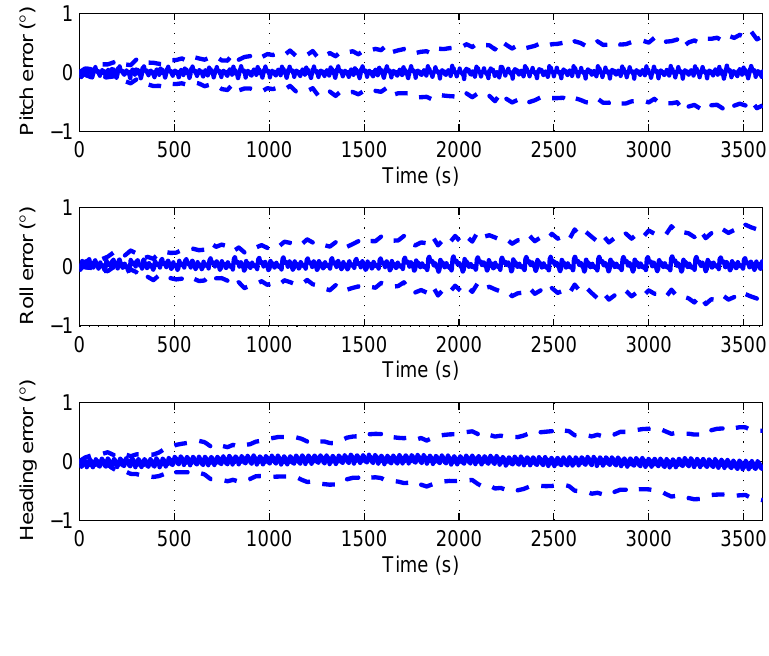
Figure 8. Average attitude and heading errors with noises added to bias and scale factor. The dash lines are 1 σ